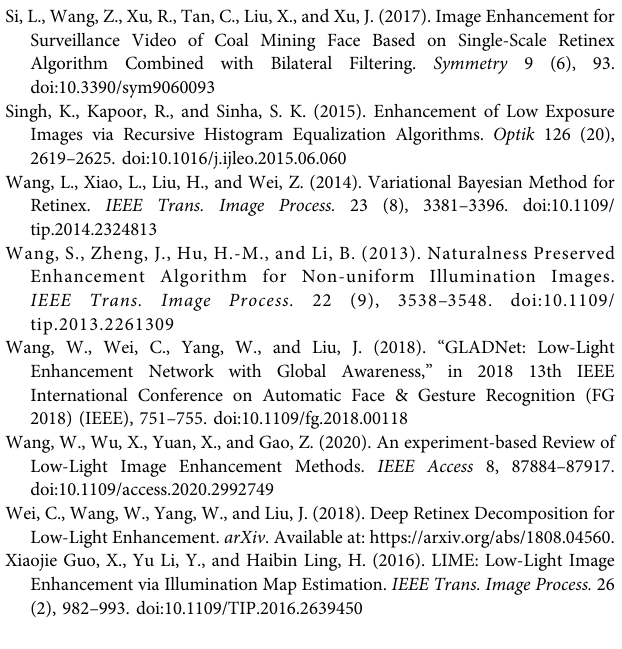
Algorithm Combined with Bilateral Filtering. Symmetry 9 (6), 93.